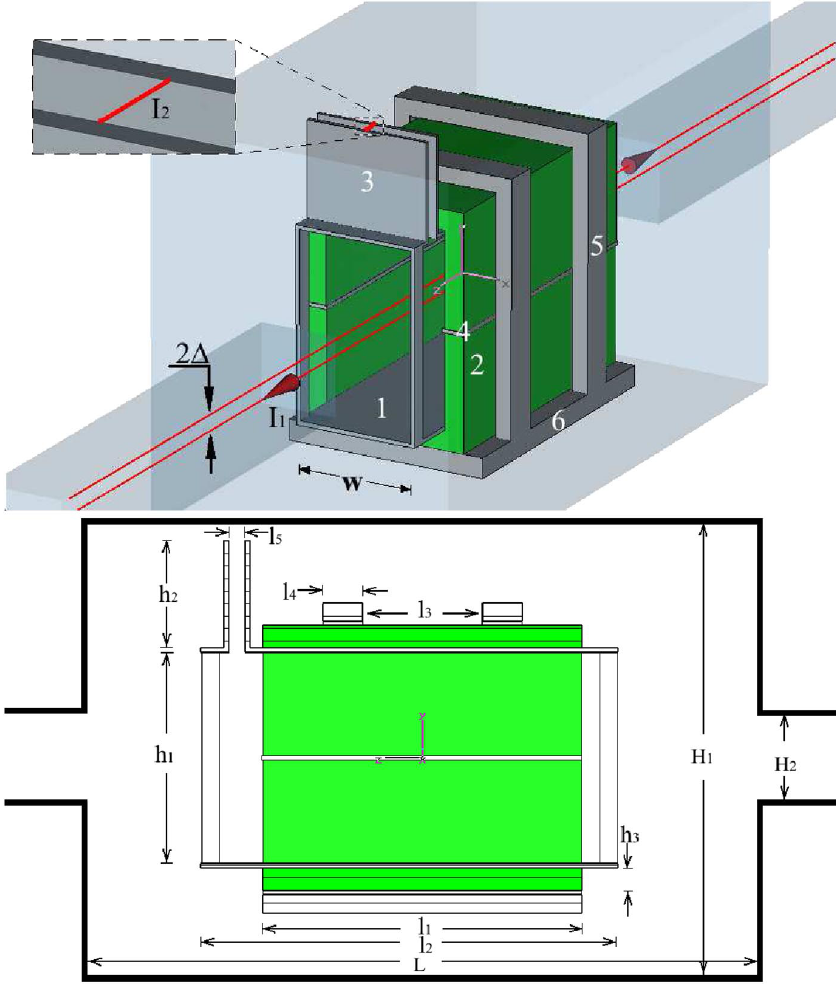
FIG. 3. (Color) Upper panel: schematic view of the SNS kicker with the metallic busbar (1), the ferrite frame (2), the end plates of the busbar (3), the strips (4), a metallic frame (5), and a metallic base (6). In the inset is shown schematically the FIT edge joining the two ends of the end plates. Lower panel: vertical cutting plane yz at x (cid:6) 0 of the kicker magnet. Kicker dimensions: w (cid:6) 15 : 9 cm , (cid:6) 24 : 8 cm , h (cid:6) 12 cm , h (cid:6) 2 : 54 cm , l (cid:6) 36 cm , l (cid:6) 46 cm , l (cid:6) 13 cm , l (cid:6) 4 : 5 cm , and l (cid:6) l (cid:6) 2 : 54 cm [3,20]. A h 1 2 3 1 2 3 4 5 6 0.3 mm-thick vacuum layer between the ferrite frame (2) and the metallic frame (5) and base (6) simulating an insulate layer is taken (cid:6) 53 cm , and H (cid:6) 10 cm into account. Typical dimensions of the vacuum vessel: L (cid:6) 76 cm , H 1 2